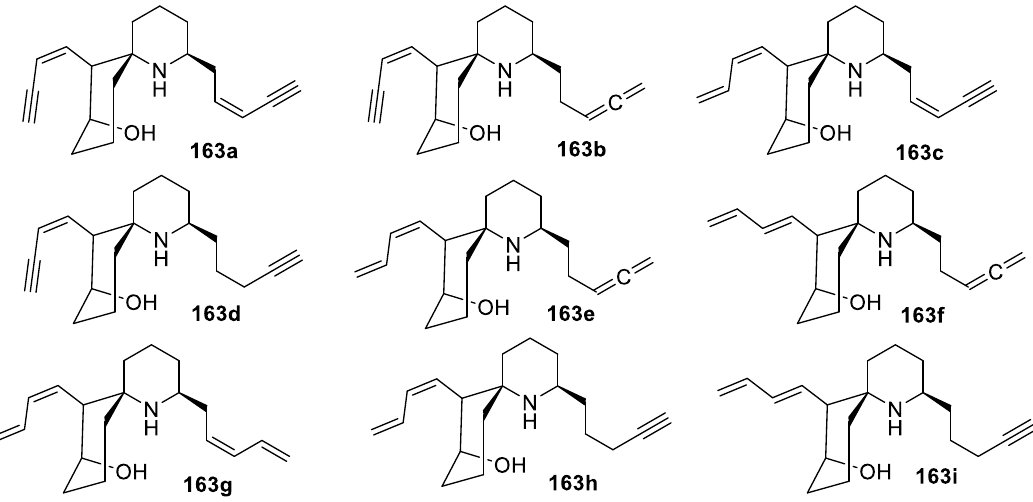
Figure 75. Bioactive [5.5.0] spirocyclic meroterpenoids isolated from mangrove-derived fungus Penicillium sp.